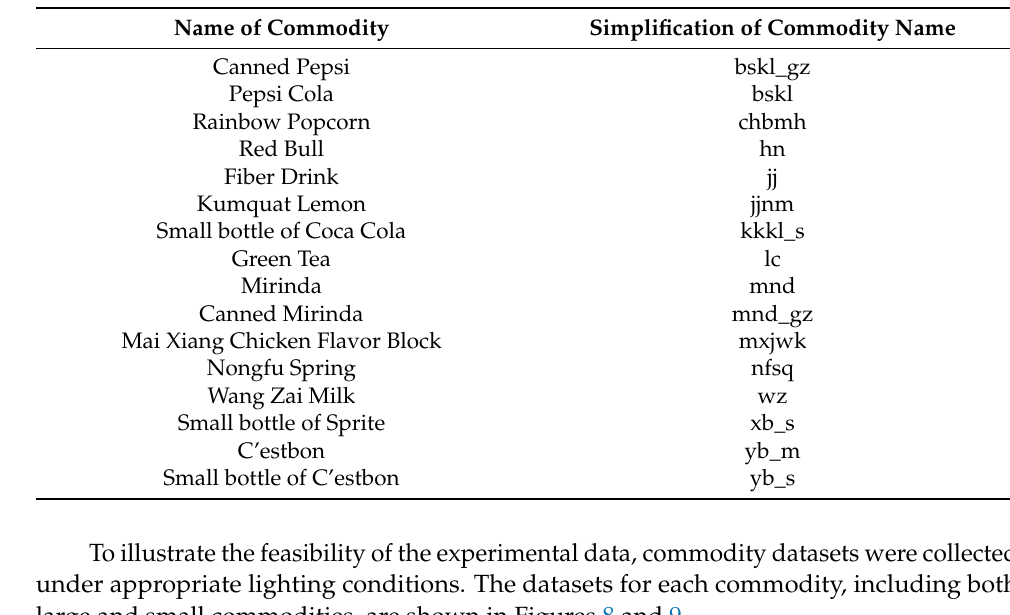
Table 1. The simplified table of commodity names.